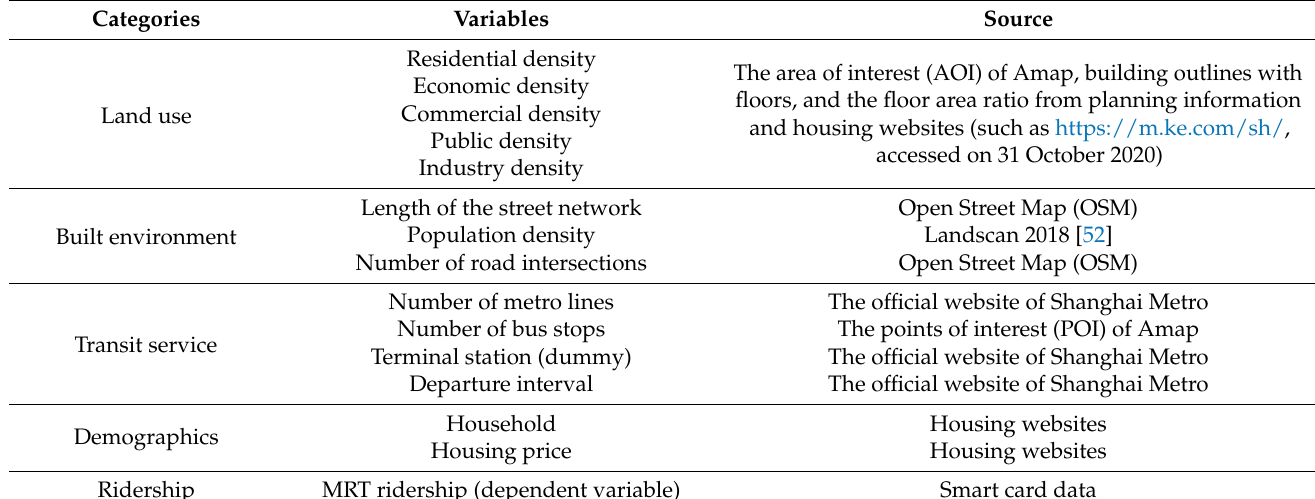
Table 1. Data description for the variables of the ridership